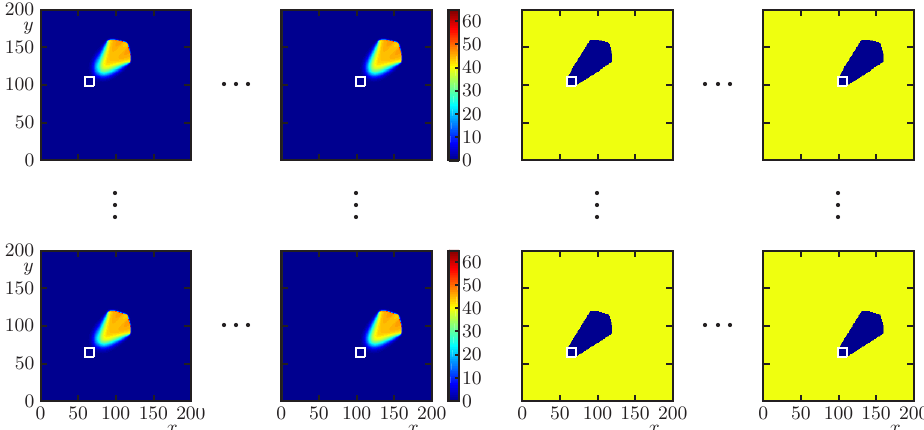
Figure 7. Scenario 3.1: principle of construction of a risk map for a flat domain. Here and in Scenarios 3.2 to 3.4, the propagation of a wildfire is simulated starting from an array of 5 5 = 25 initial fire foci, × marked by small white squares. For each initial position the simulation is stopped when 5% of the initially available fuel is burnt. The corresponding times T risk are mapped in Figure 8. (For the present flat case, the shapes of the temperature and fuel distributions are the always the same in relation to the initial fire; instead of displaying 2 25 identical results, we only show the ‘corner’ cases of the 5 5 × × initial positions).